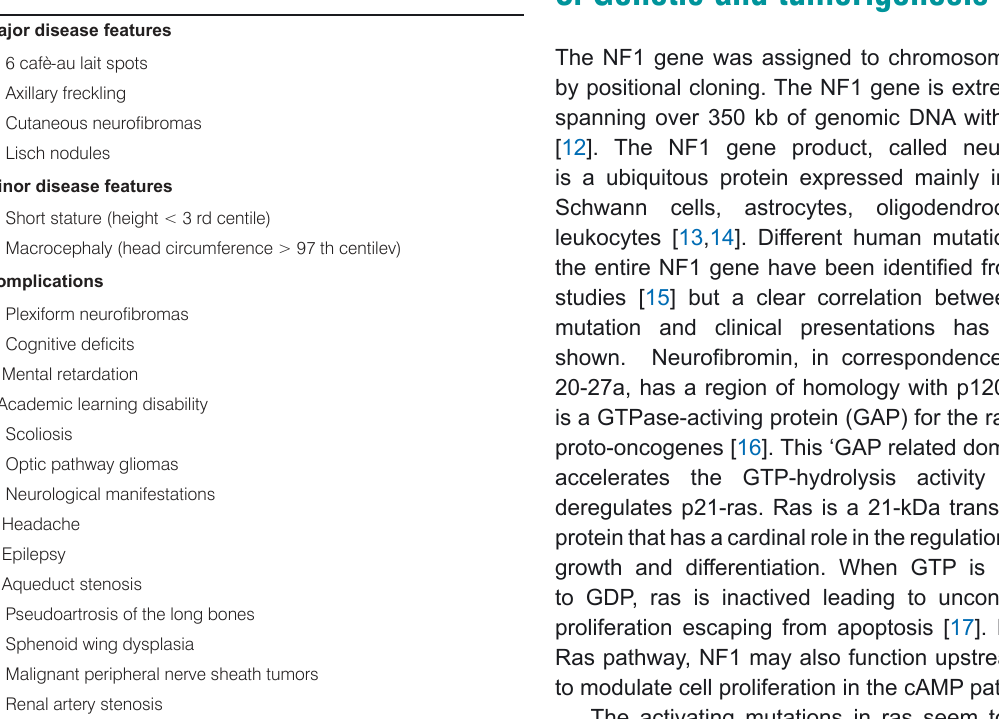
Table 1. Clinical Features of NF1.